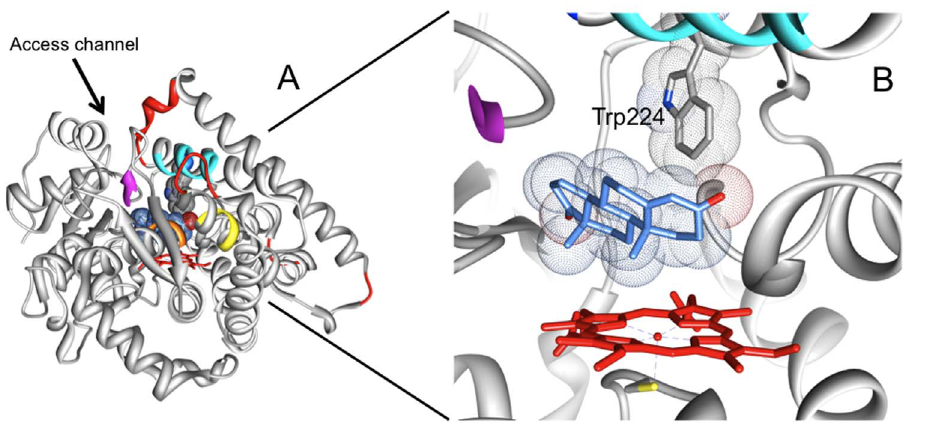
Figure 5. Access channel of rArom for the substrate androstenedione. A) Overall structure of rArom (PDB ID 4KQ8). The most flexible regions according to the MD simulations [18] are shown in red. The parts of the secondary structure elements forming the access channel are shown in yellow (helix E), cyan (helix F), orange (helix)I, magenta ( b -strand 9). B) Zoom in the active site: the heme is shown in red, the Van der Waals surface of androstenedione (blue) and Trp224 (grey) are also shown.